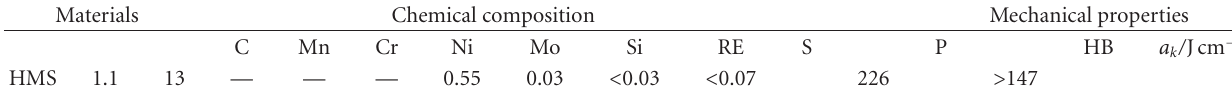
Table 1: Chemical composition and mechanical properties of HMS.